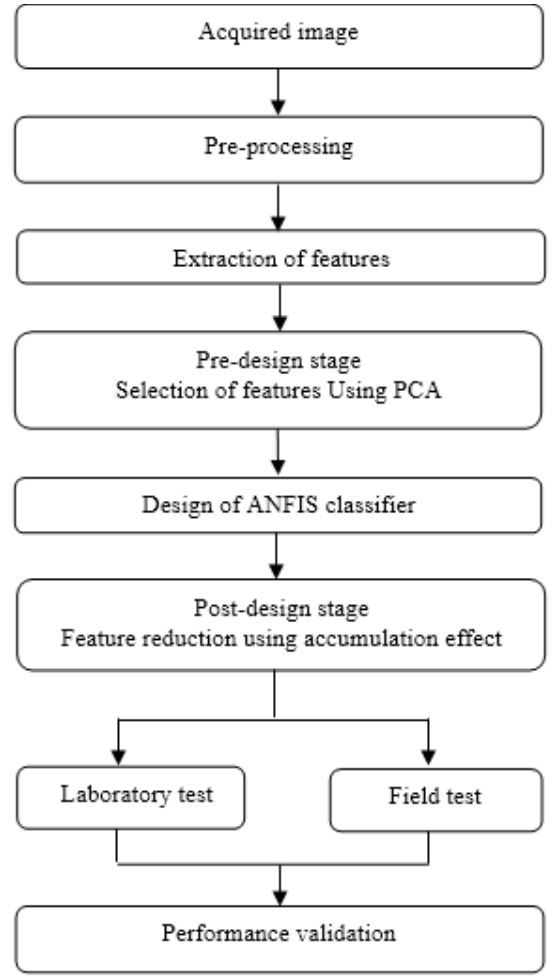
Figure 3. Steps in the design of the ANFIS classifier.